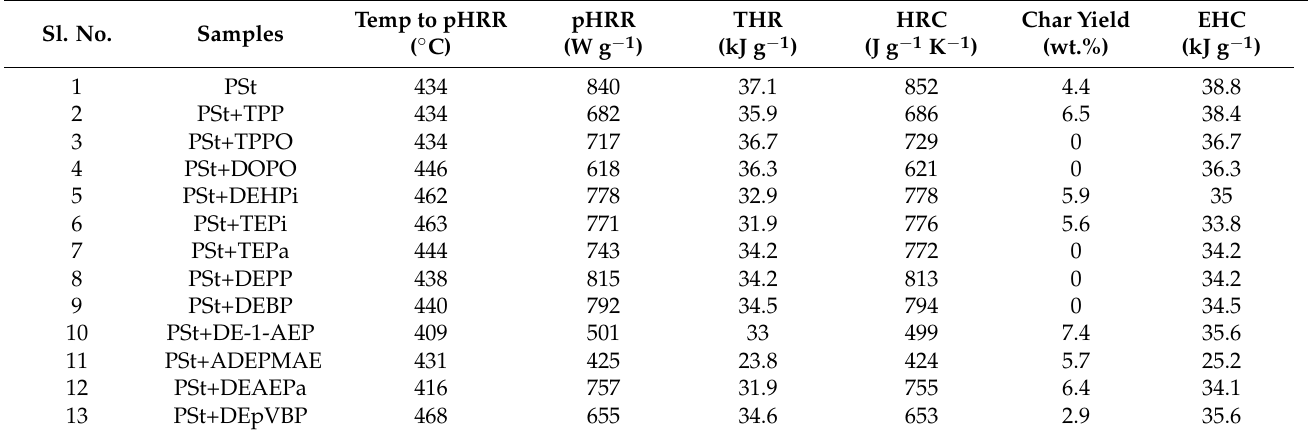
Table 5. PCFC data of PSt-based